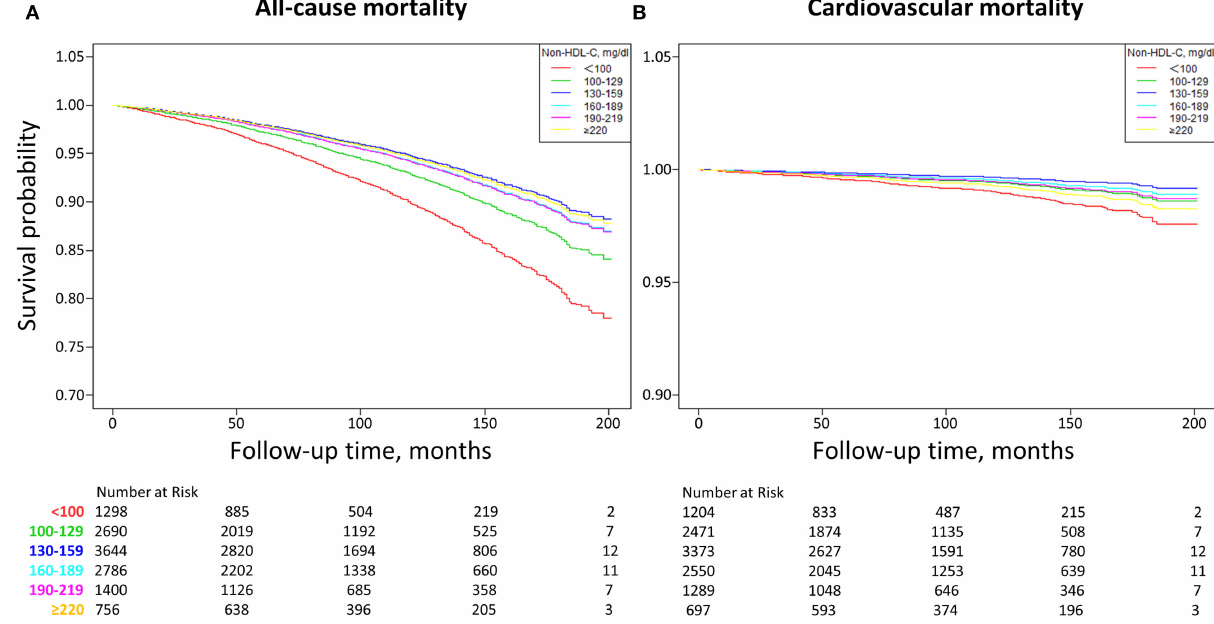
no). All statistical analyses were performed using R version 3.3.2